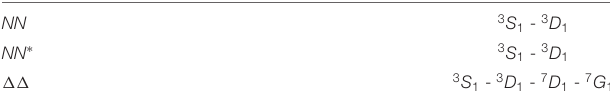
TABLE 3 | Different channels and partial waves considered in the calculation of the deuteron properties from Juliá-Díaz et al.